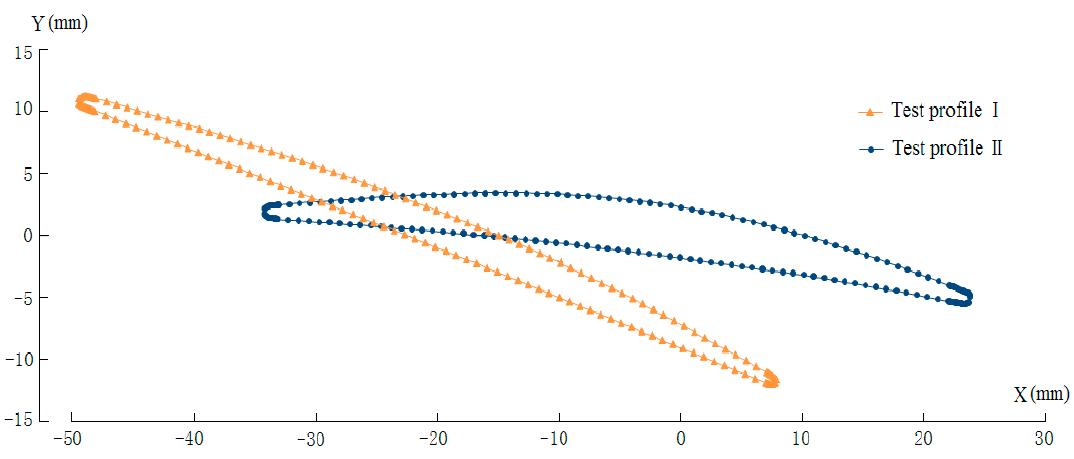
Figure 9. Measurement curves of test profiles.